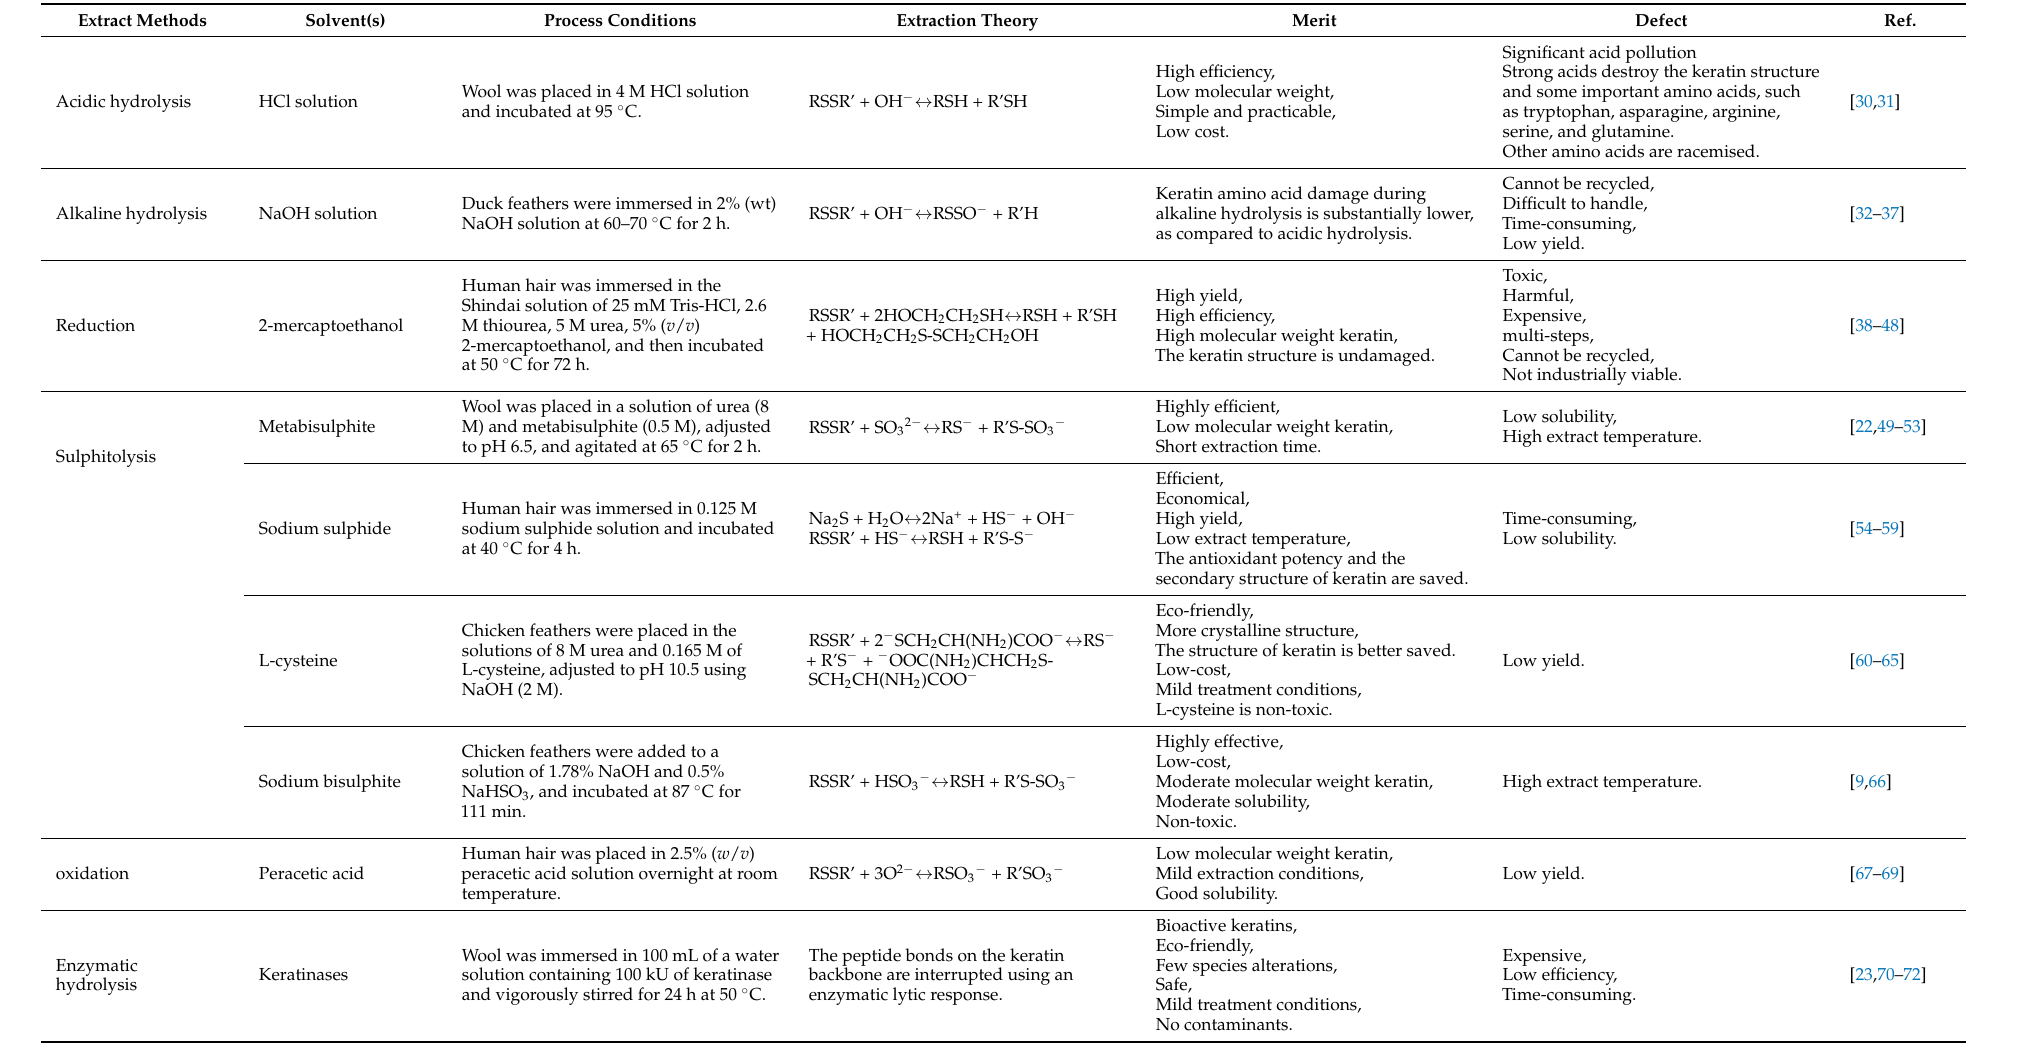
Table 1. Conventional keratin extraction